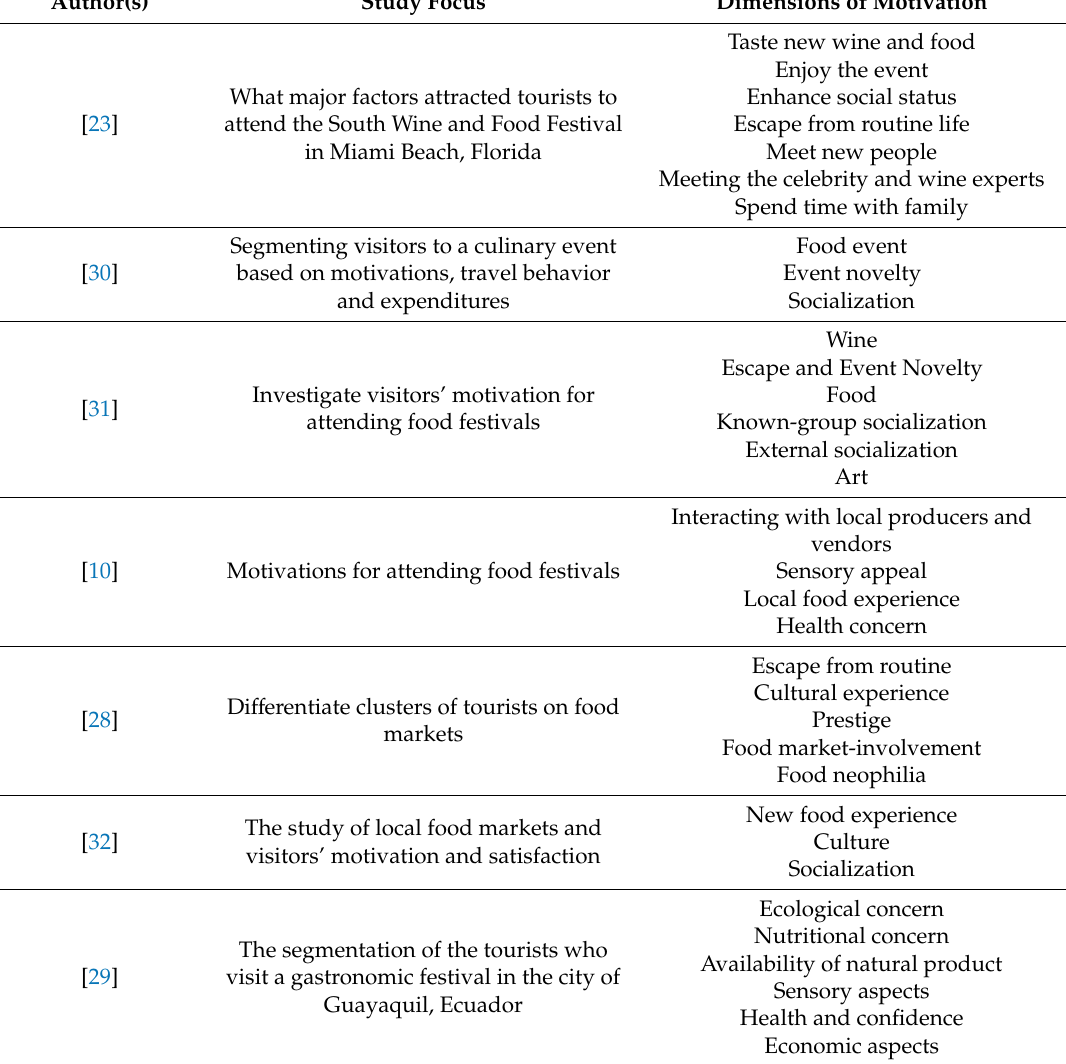
Table 1. Motivation dimensions of gastronomic markets, events and